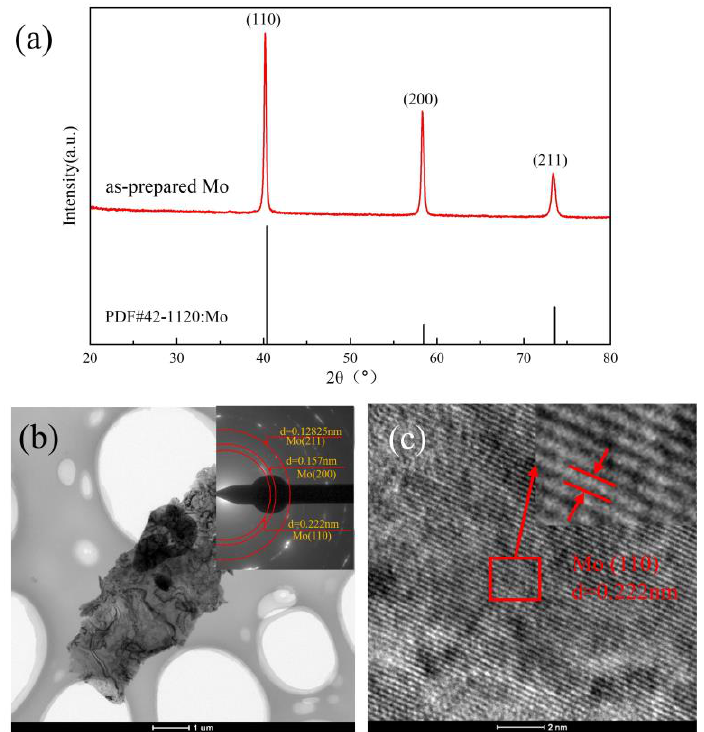
Figure 1. ( a ) XRD pattern, ( b ) TEM image, and ( c ) HRTEM image of as-prepared Mo. SAED pattern was also compiled in ( b ).